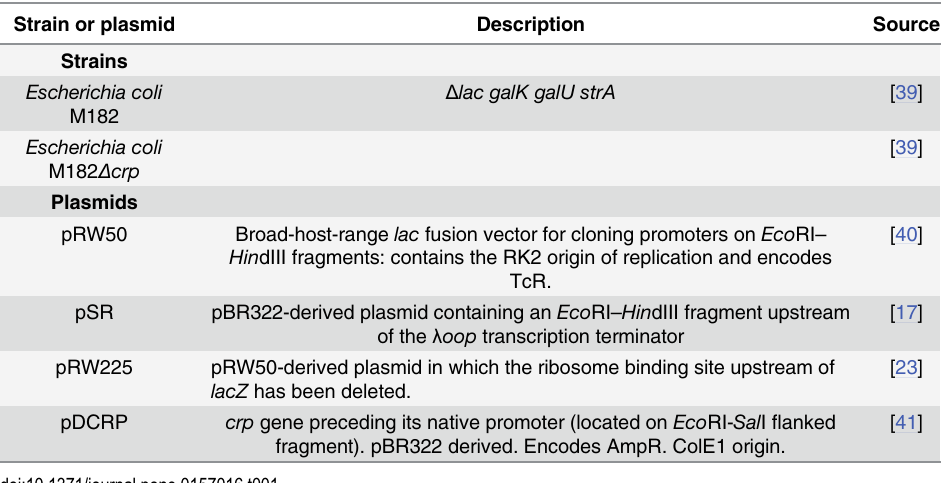
Table 1. Strains and plasmids used in this study.